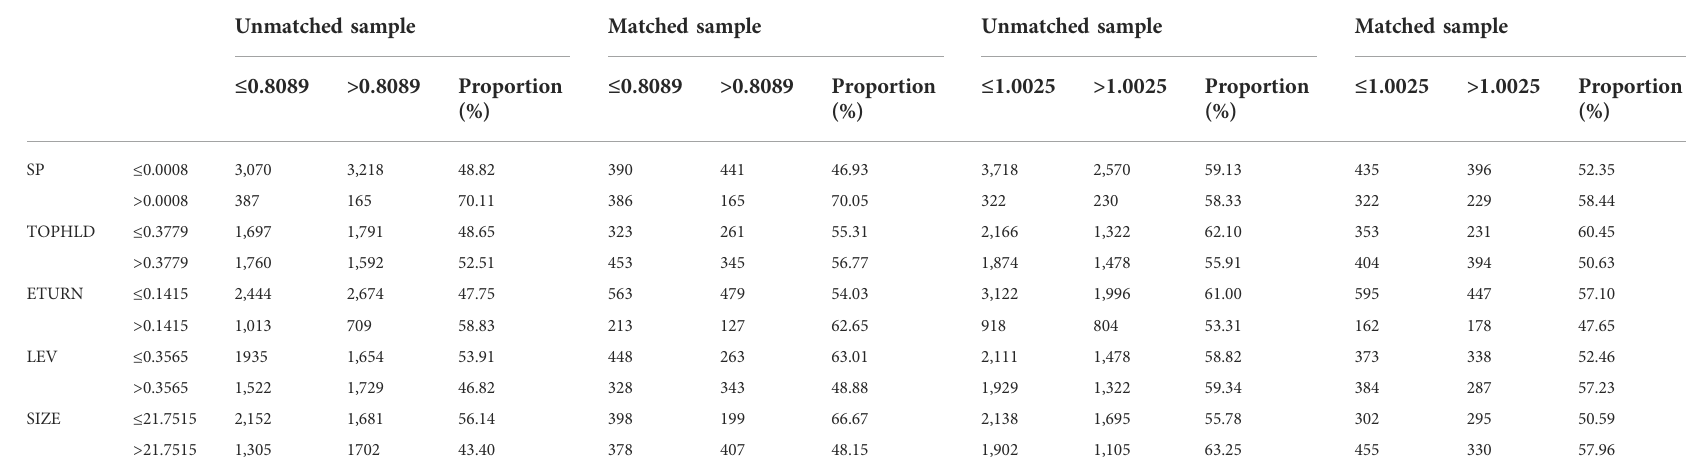
TABLE 6 Description of statistics before and after PSM